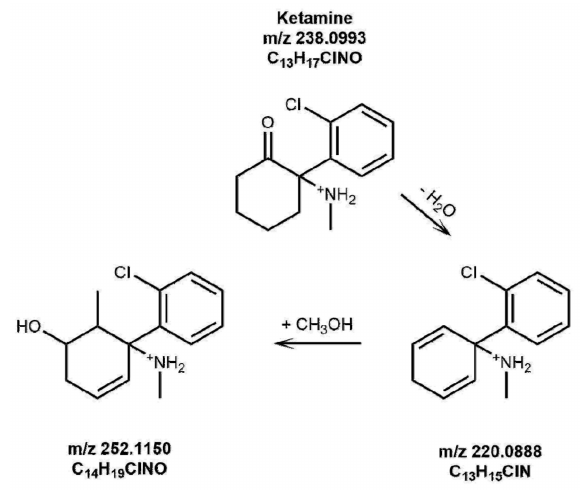
Figure 2. Proposed structures of KET photoproducts formed in a methanol solution upon irradiation for 3